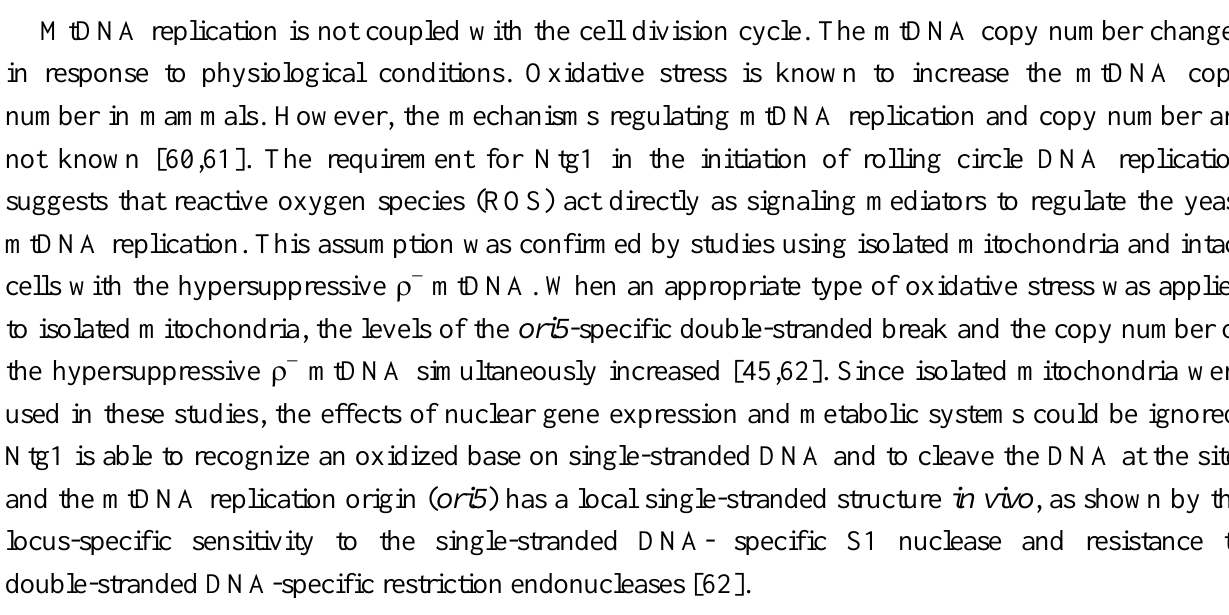
Figure 4. ROS mediated double-stranded breakage at the mtDNA replication origin,